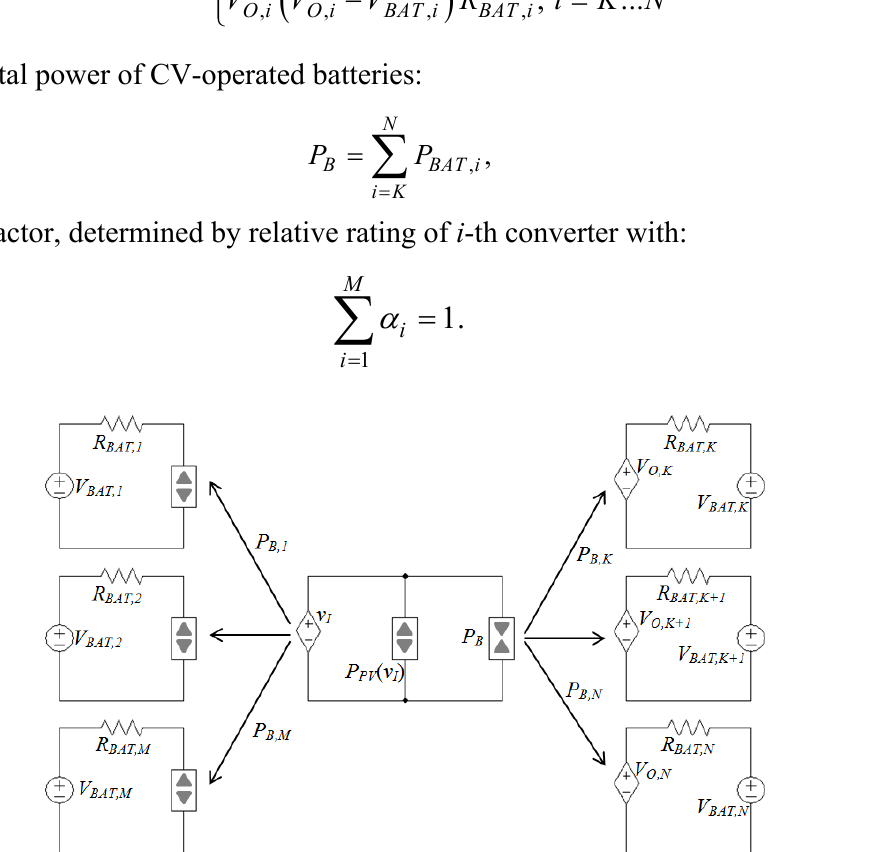
Figure 13. Power flow diagram of a multi-battery system.